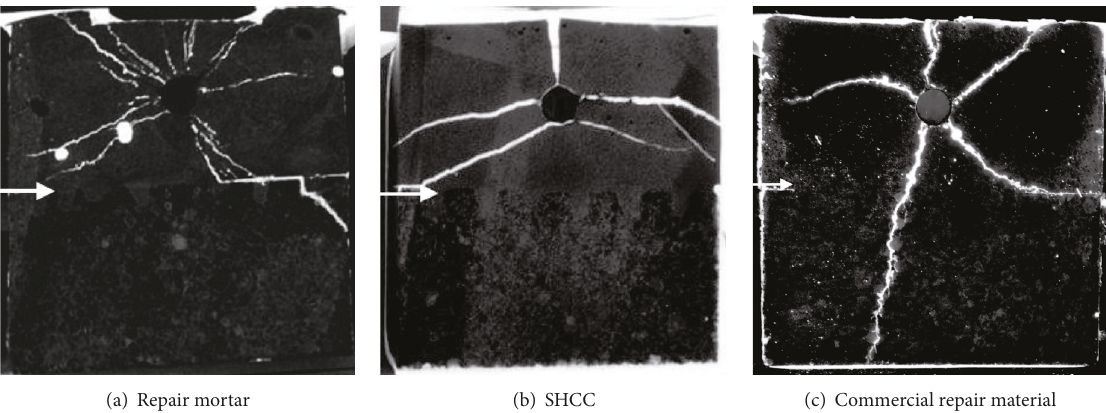
Figure 17: Numerically obtained crack pattern and maximum crack widths due to the pressure imposed by expanding bar in repair systems and influence of different types of repair materials; top: repair material; bottom: substrate (deformation scaled 20x; note that for different samples maximum crack widths are different).